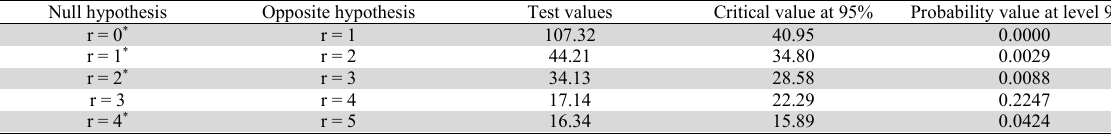
The results of maximum eigenvalues